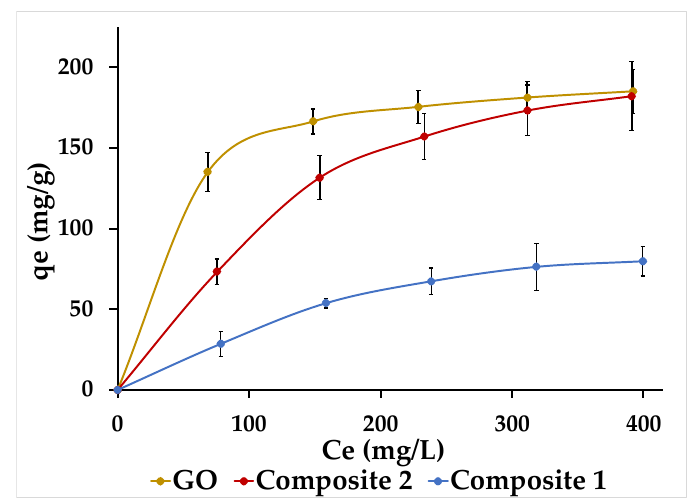
Figure 12. Isotherms for Pb(II) adsorption onto GO and composites; pH of the solution = 5; V = 50 mL; MSOLID = 5 mg; agitation = 250 rpm; T = 20 ◦ C. Table 2. Parameters associated with the Langmuir and Freundlich isotherms for the adsorption of Pb(II) in the synthesized compounds.